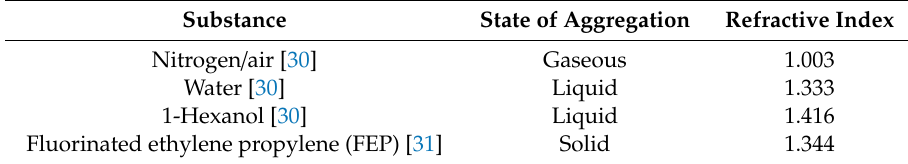
Table 1. Refractive indices of the substances considered, with air being considered to have the same refractive index as